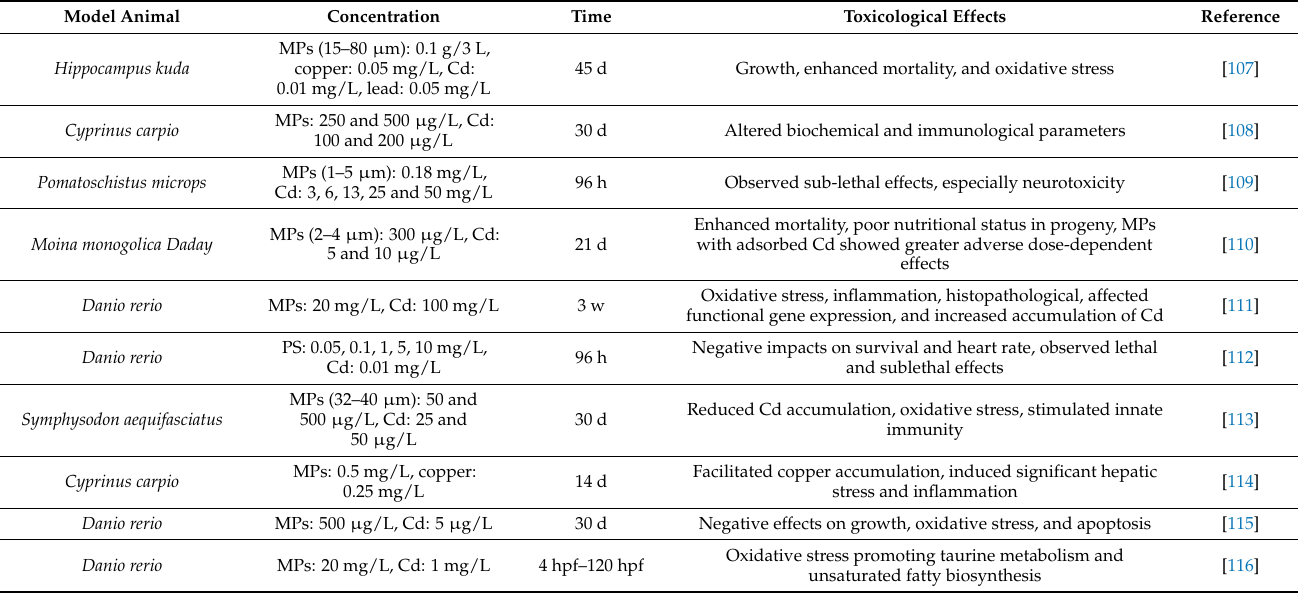
Table 4. Related studies on the comprehensive stress of MPs and heavy metals on aquatic